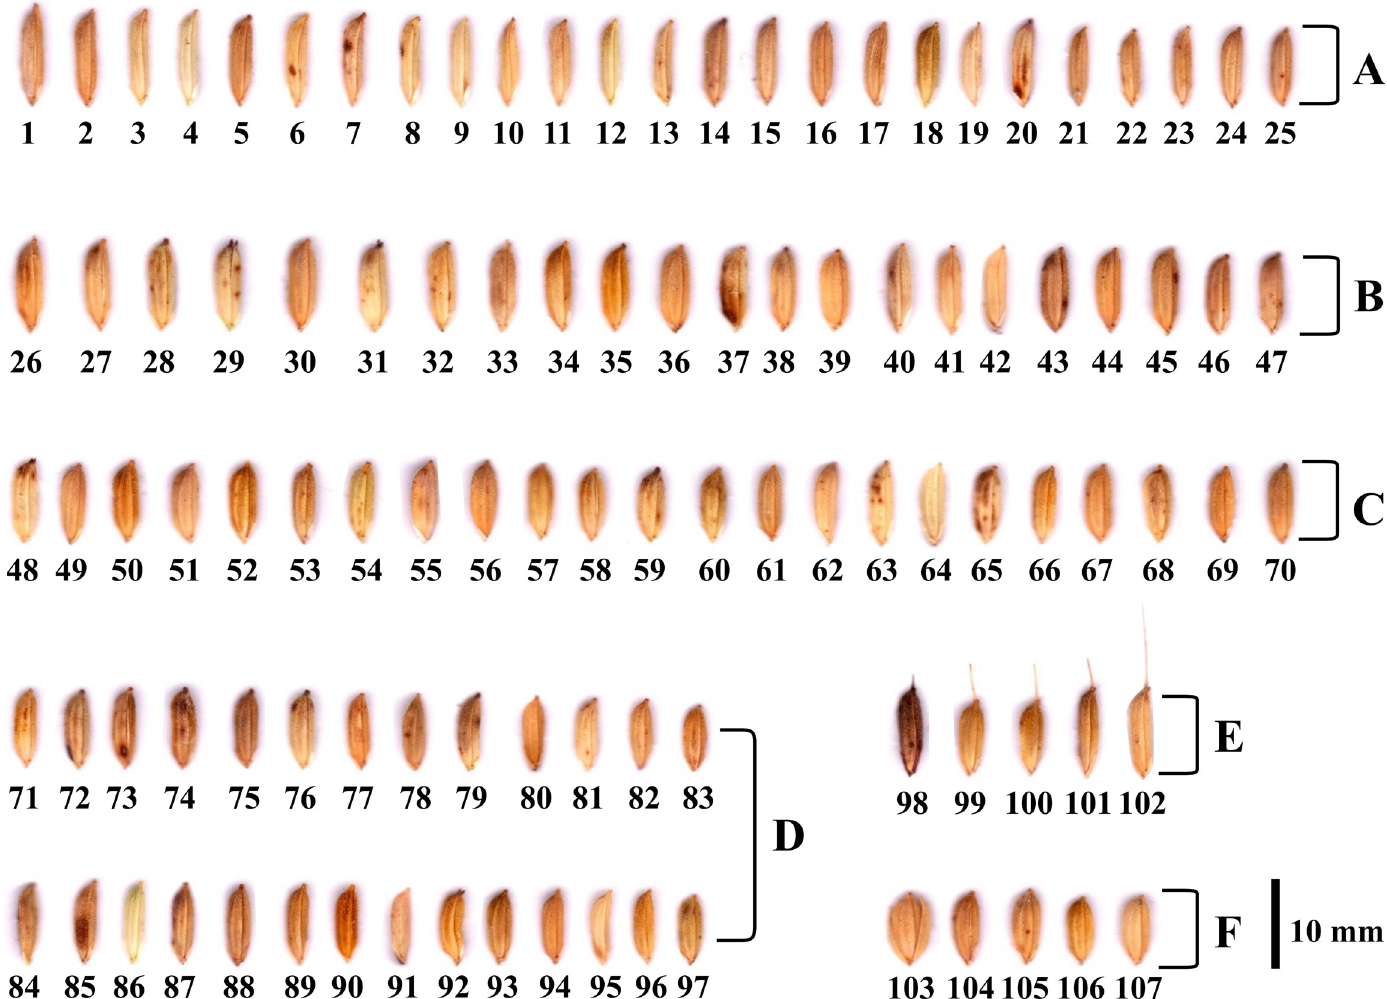
Figure 3. Grain diversity of Indonesian swamp rice germplasm, showing differences among accessions. The labels A–F indicates the subspecies: A = indica ; B = javanica ; C = close to javanica ; D = close to indica ; E = indica with awn on grain tip; F = close to japonica . The name of each accession is provided in Table Mires and Peat , Volume 28 (2022), Article 35, 17 pp., http://www.mires-and-peat.net/, ISSN 1819-754X